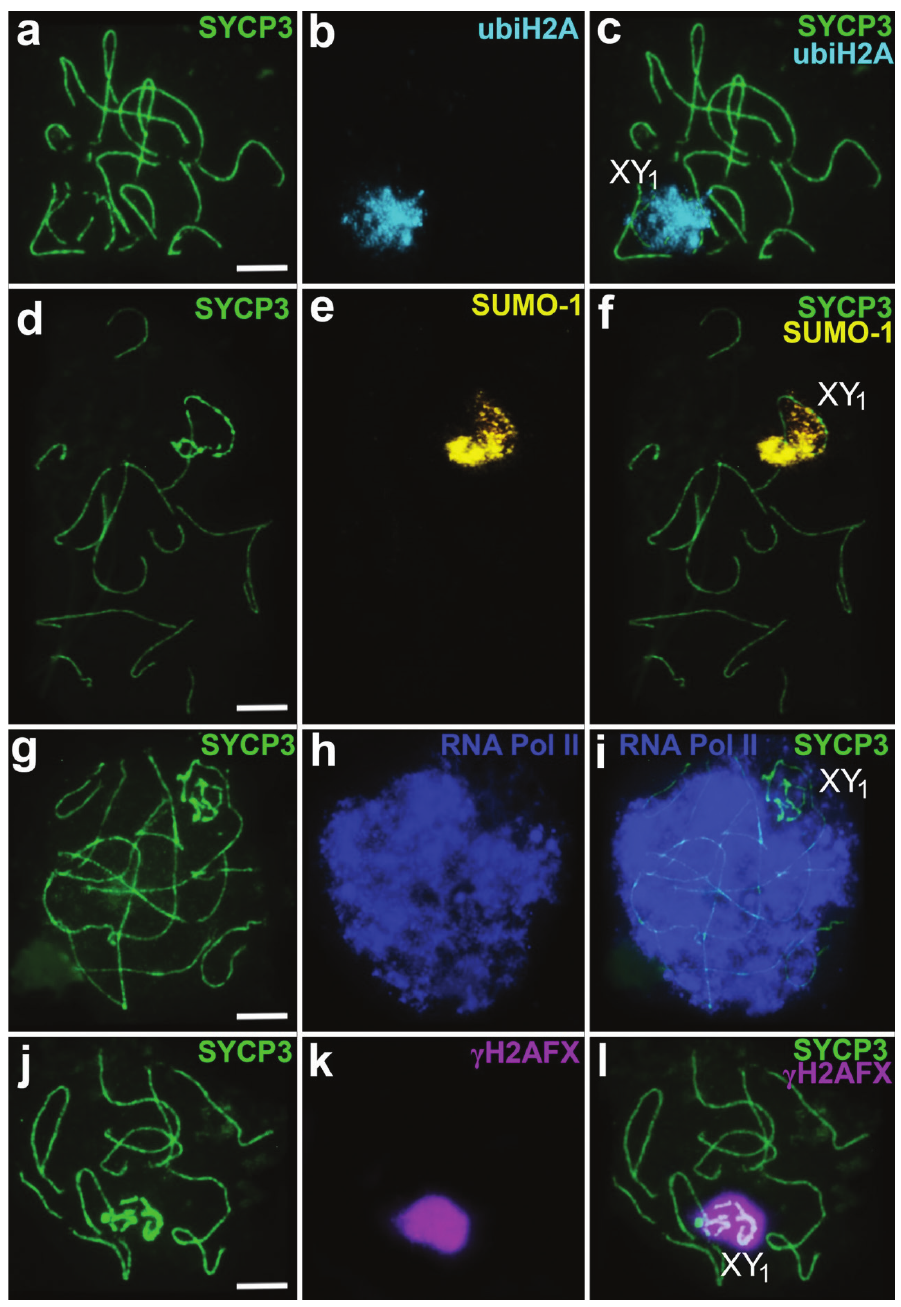
Figure 3. Mid-pachytene spermatocytes of Sorex araneus . Double immunostaining with antibodies: a– c anti-SYCP3 ( green )/anti-ubiH2A ( cyan ) d–f anti-SYCP3 ( green )/anti-SUMO-1 ( yellow ) g–i anti-SYCP3 ( green )/anti-RNA Pol II ( blue ) j–l anti-SYCP3 ( green )/anti- γ H2AFX ( violet ). The true sex chromosome region is designated as XY . Scale bars: 5 1